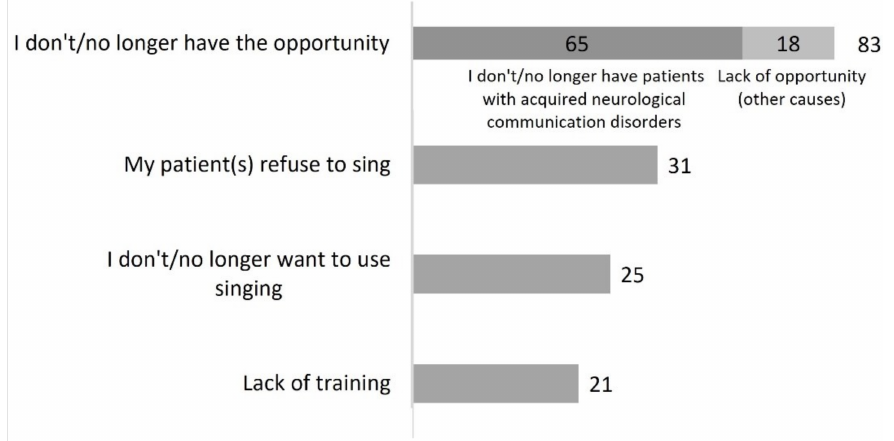
Figure 2. Reasons why participants do not/no longer use singing (question #6 of the questionnaire, 145 respondents). Table 1. Thematic analysis of open-ended answers to question 4: “Could you briefly explain how you used the singing tool with these patients?” (295